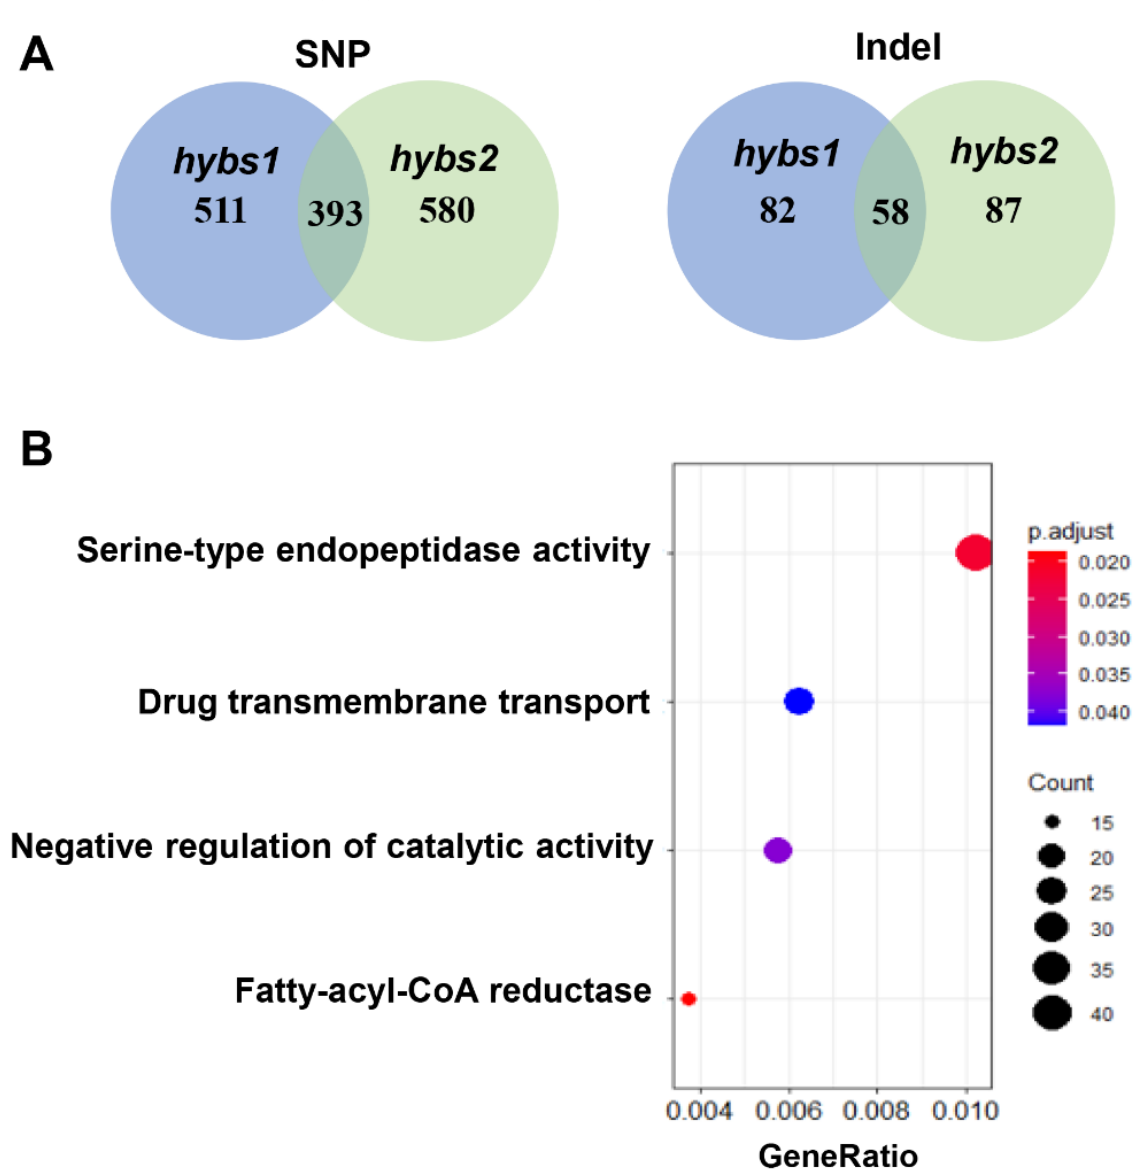
Figure 3. Annotation of SNPs and indels. ( A ) Number of genes that large-effect SNPs and indels occurred. ( B ) GO enrichment analysis of genes with large-effect SNPs and indels.